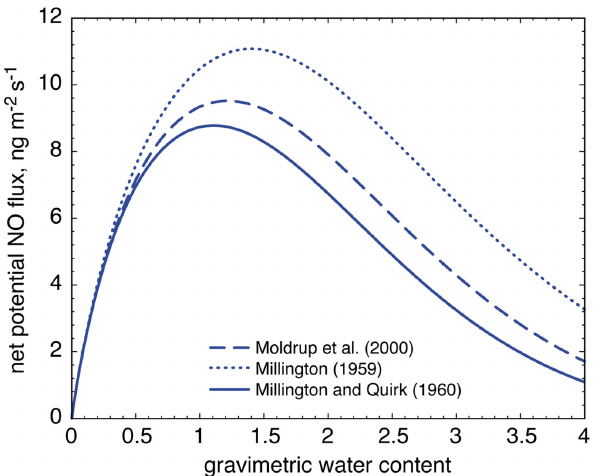
Figure 3. Net potential NO flux at 10°C from a grass covered patch (all expressed in terms of Fig. 3. Net potential NO flux at 10 ◦ C from a grass covered patch mass of nitrogen). The net potential NO fluxes were calculated according to Eq. (8) applying (all expressed in terms of mass of nitrogen). The net potential NO effective soil diffusion coefficients by Moldrup et al. (2000), Millington (1959) and fluxes were calculated according to Eq. (8) applying effective soil Millington and Quirk (1960) (see Tab. 1). diffusion coefficients by Moldrup et al. (2000), Millington (1959) and Millington and Quirk (1960) (see Table 1).